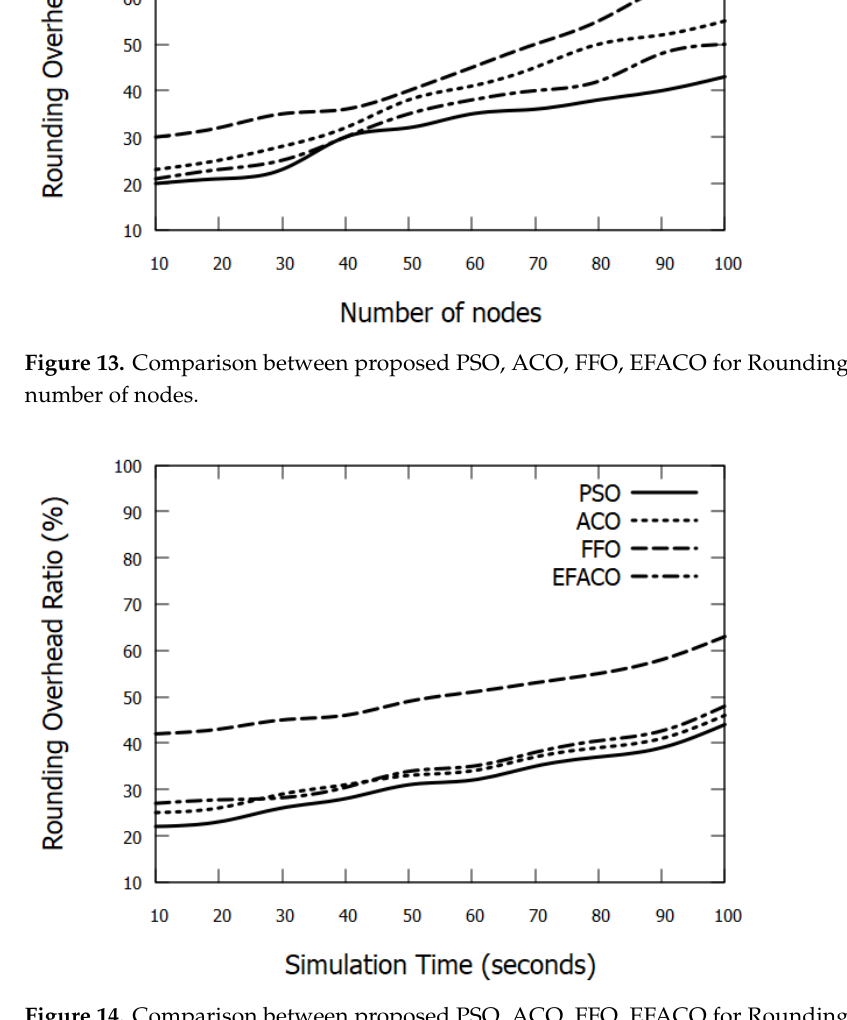
Figure 14. Comparison between proposed PSO, ACO, FFO, EFACO for Rounding Overhead with simulation